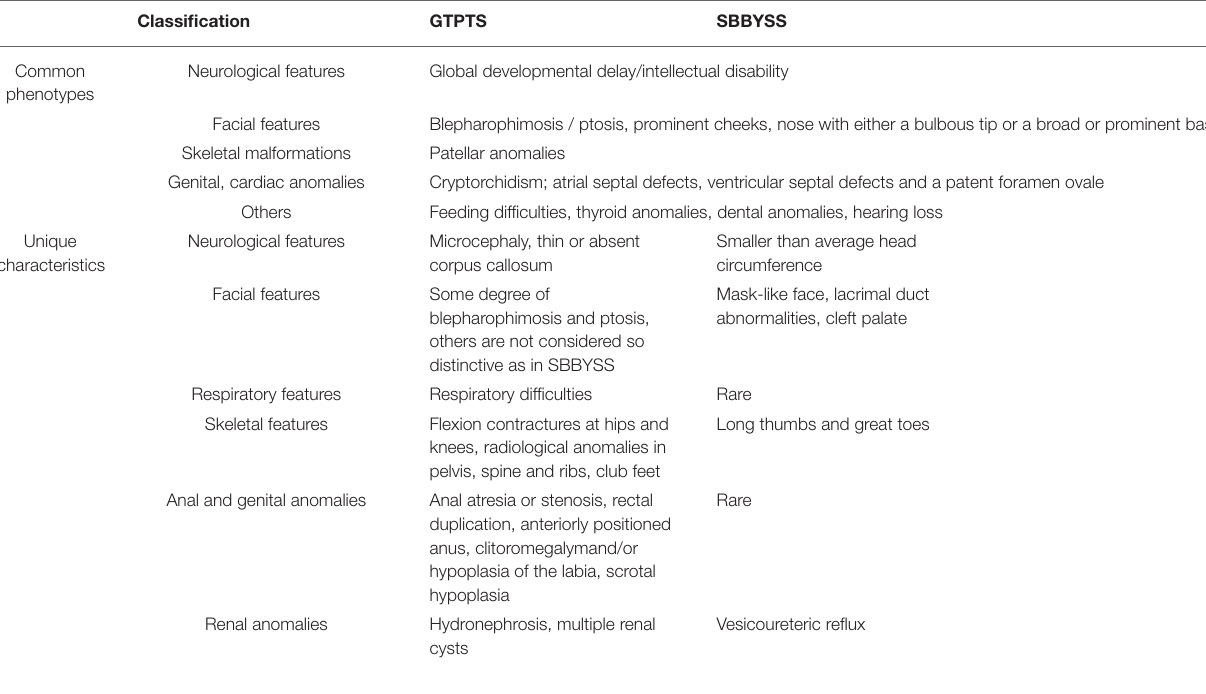
TABLE 1 | The common phenotypes and unique characteristics of GTPTS and